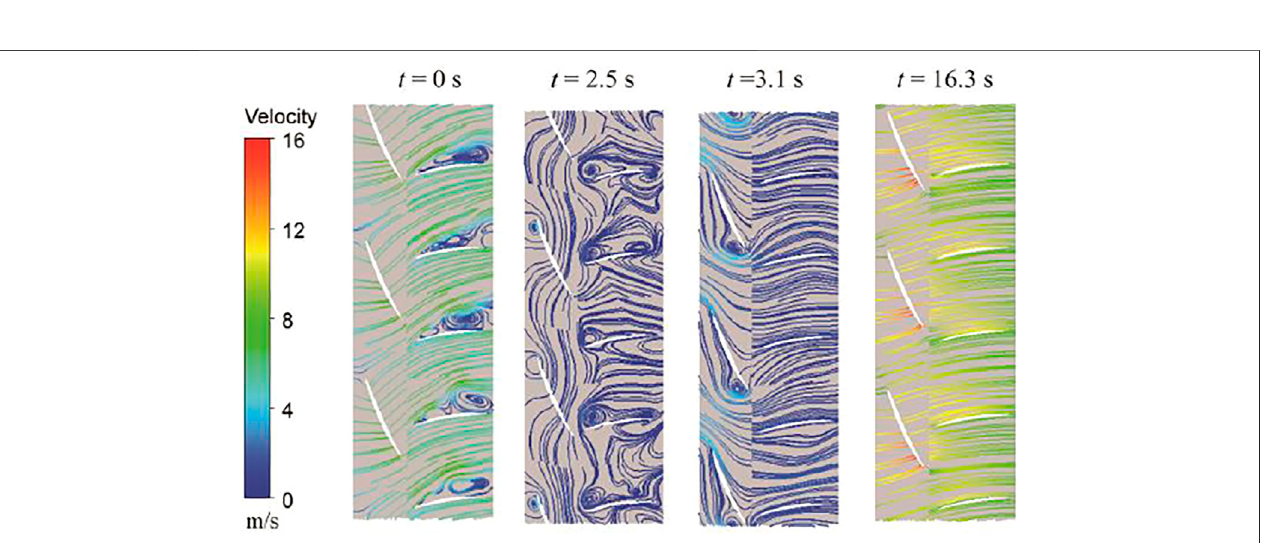
FIGURE 9 | Streamline distribution and static pressure contours in the horizontal plane of the pump: (A) t = 0 s; (B) t =2.5 s; (C) t = 3.1 s; (D) t = 16.3 s.